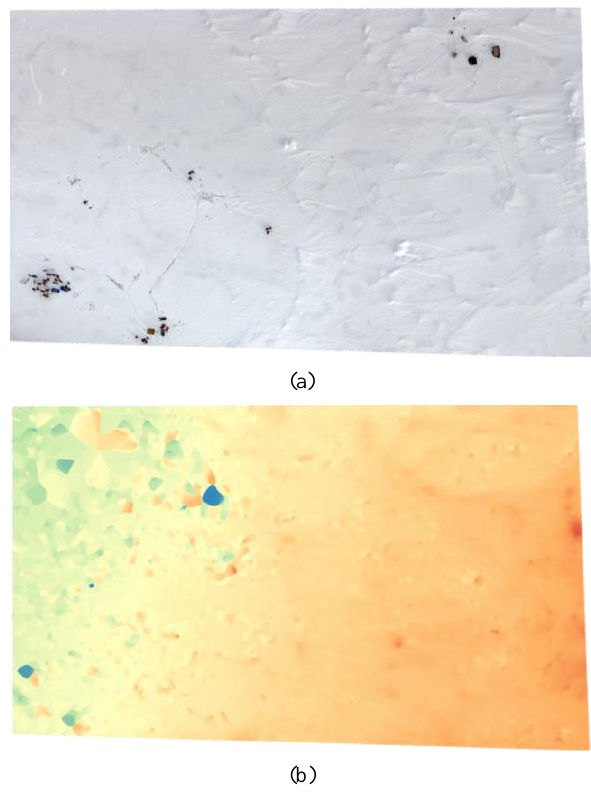
Figure 6. Ortho-mosaic and DSM derived from UAV images for the target area. (a) ortho-mosaic and (b) DSM.